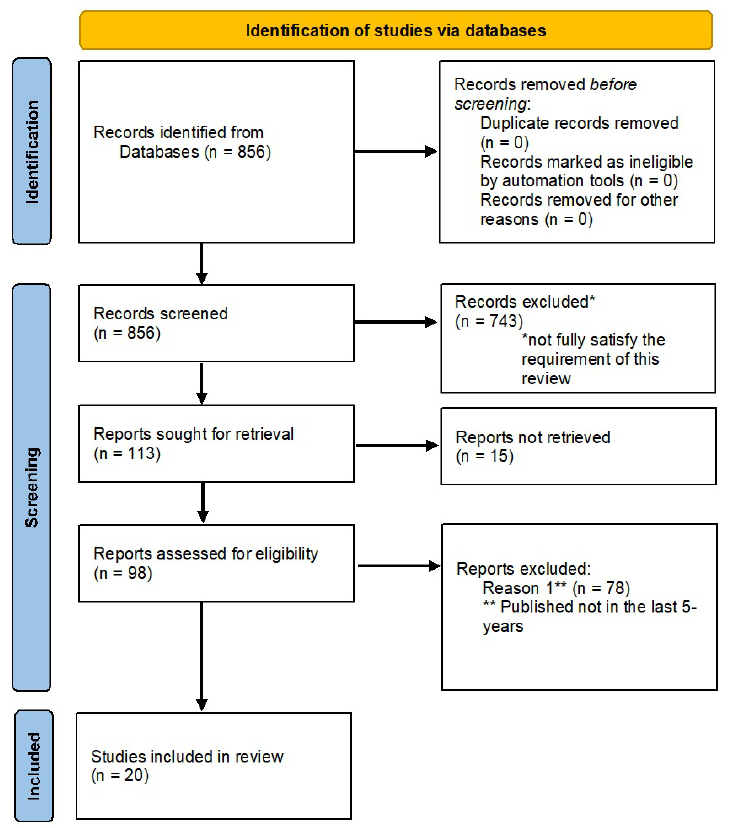
Figure 2. Flow diagram about research